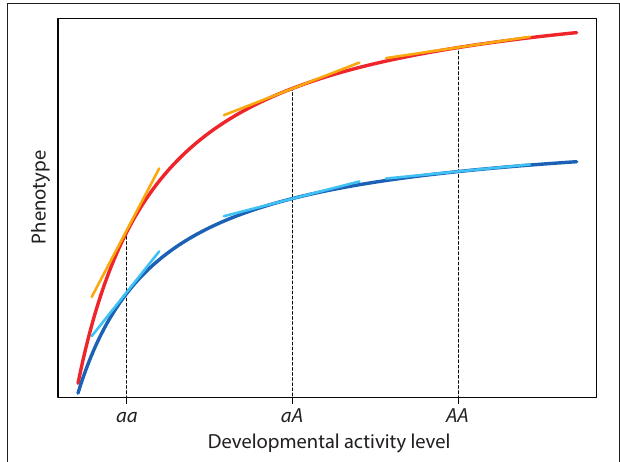
FIGURE 6 | Developmental mapping of the level of some developmental activity to the phenotype in two different environments. For the curves corresponding to both environments, tangents are drawn at the developmental activity levels of the aa , aA, and AA genotypes to indicate the sensitivity to developmental noise for the six genotype–environment